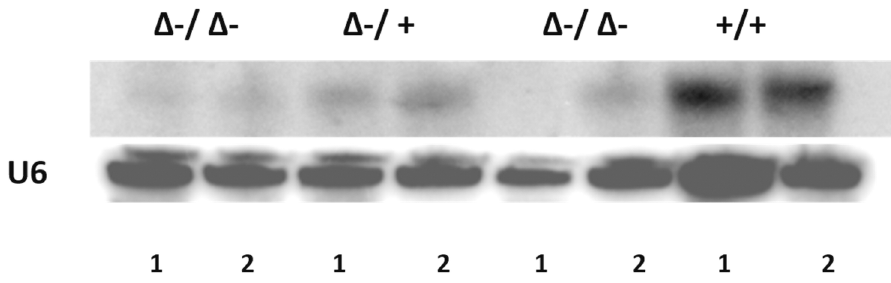
doi:10.1371/journal.pone.0131981.g001